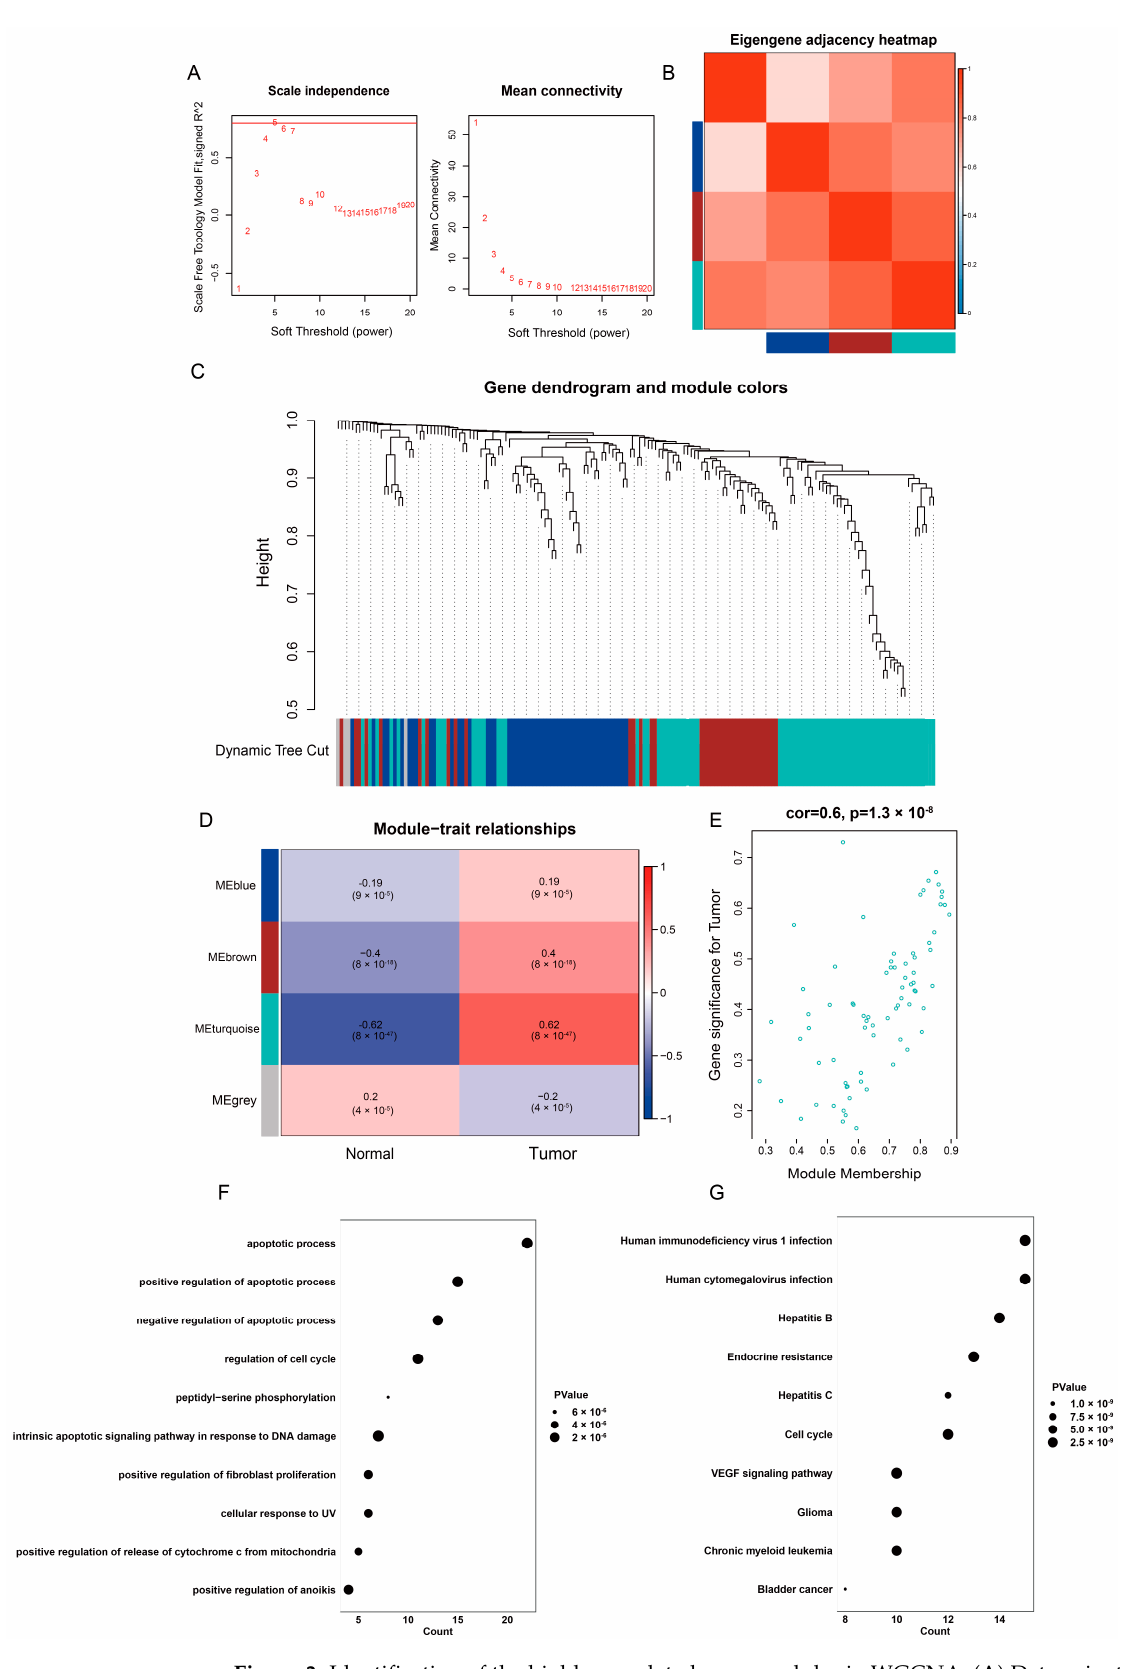
Figure 3. Identification of the highly correlated gene modules in WGCNA. ( A ) Determination of the soft thresholding power. The y -axis of the left panel represents the scale-free fit index and the y